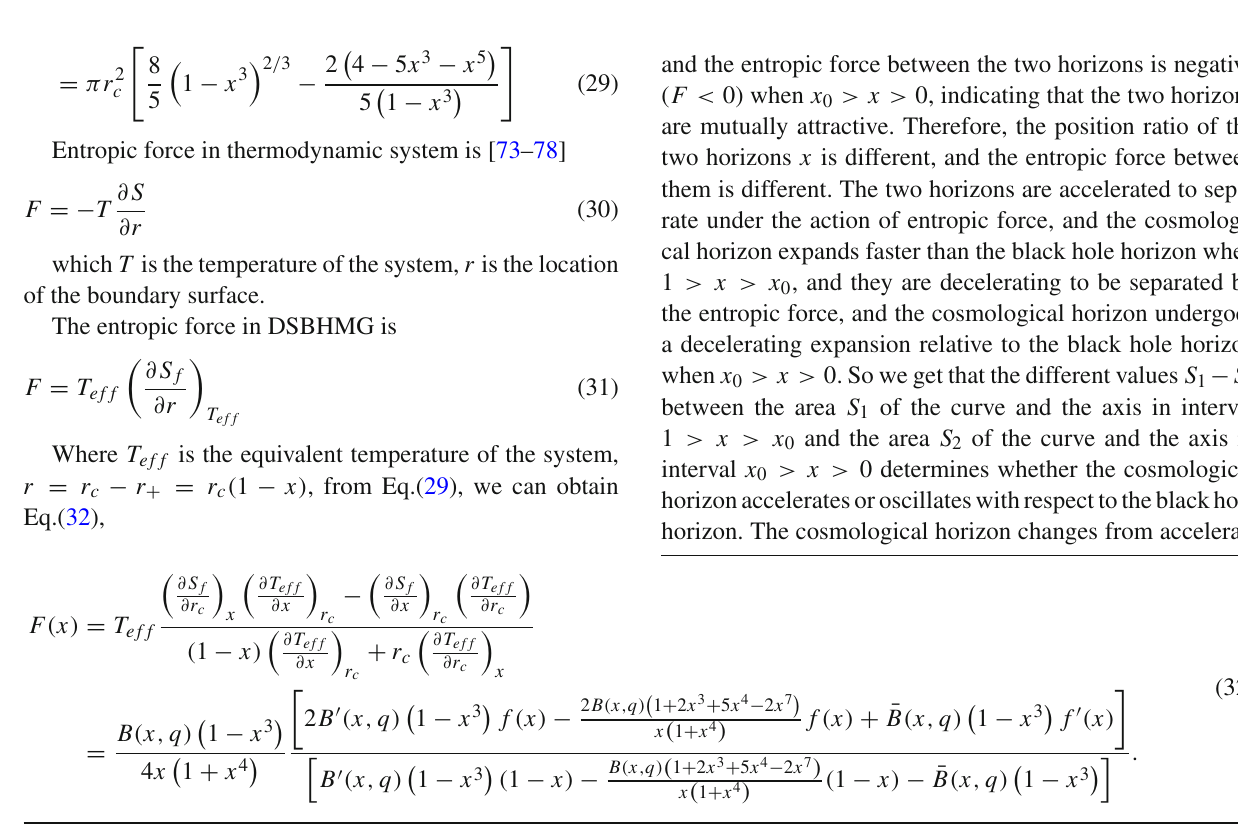
Fig. 7 G − T ef f diagrams when the parameters change respectively and the initial parameters m = 2 . 12, c 1 = 2, c 2 = 3 . 18, q = 1 . 7, r c =